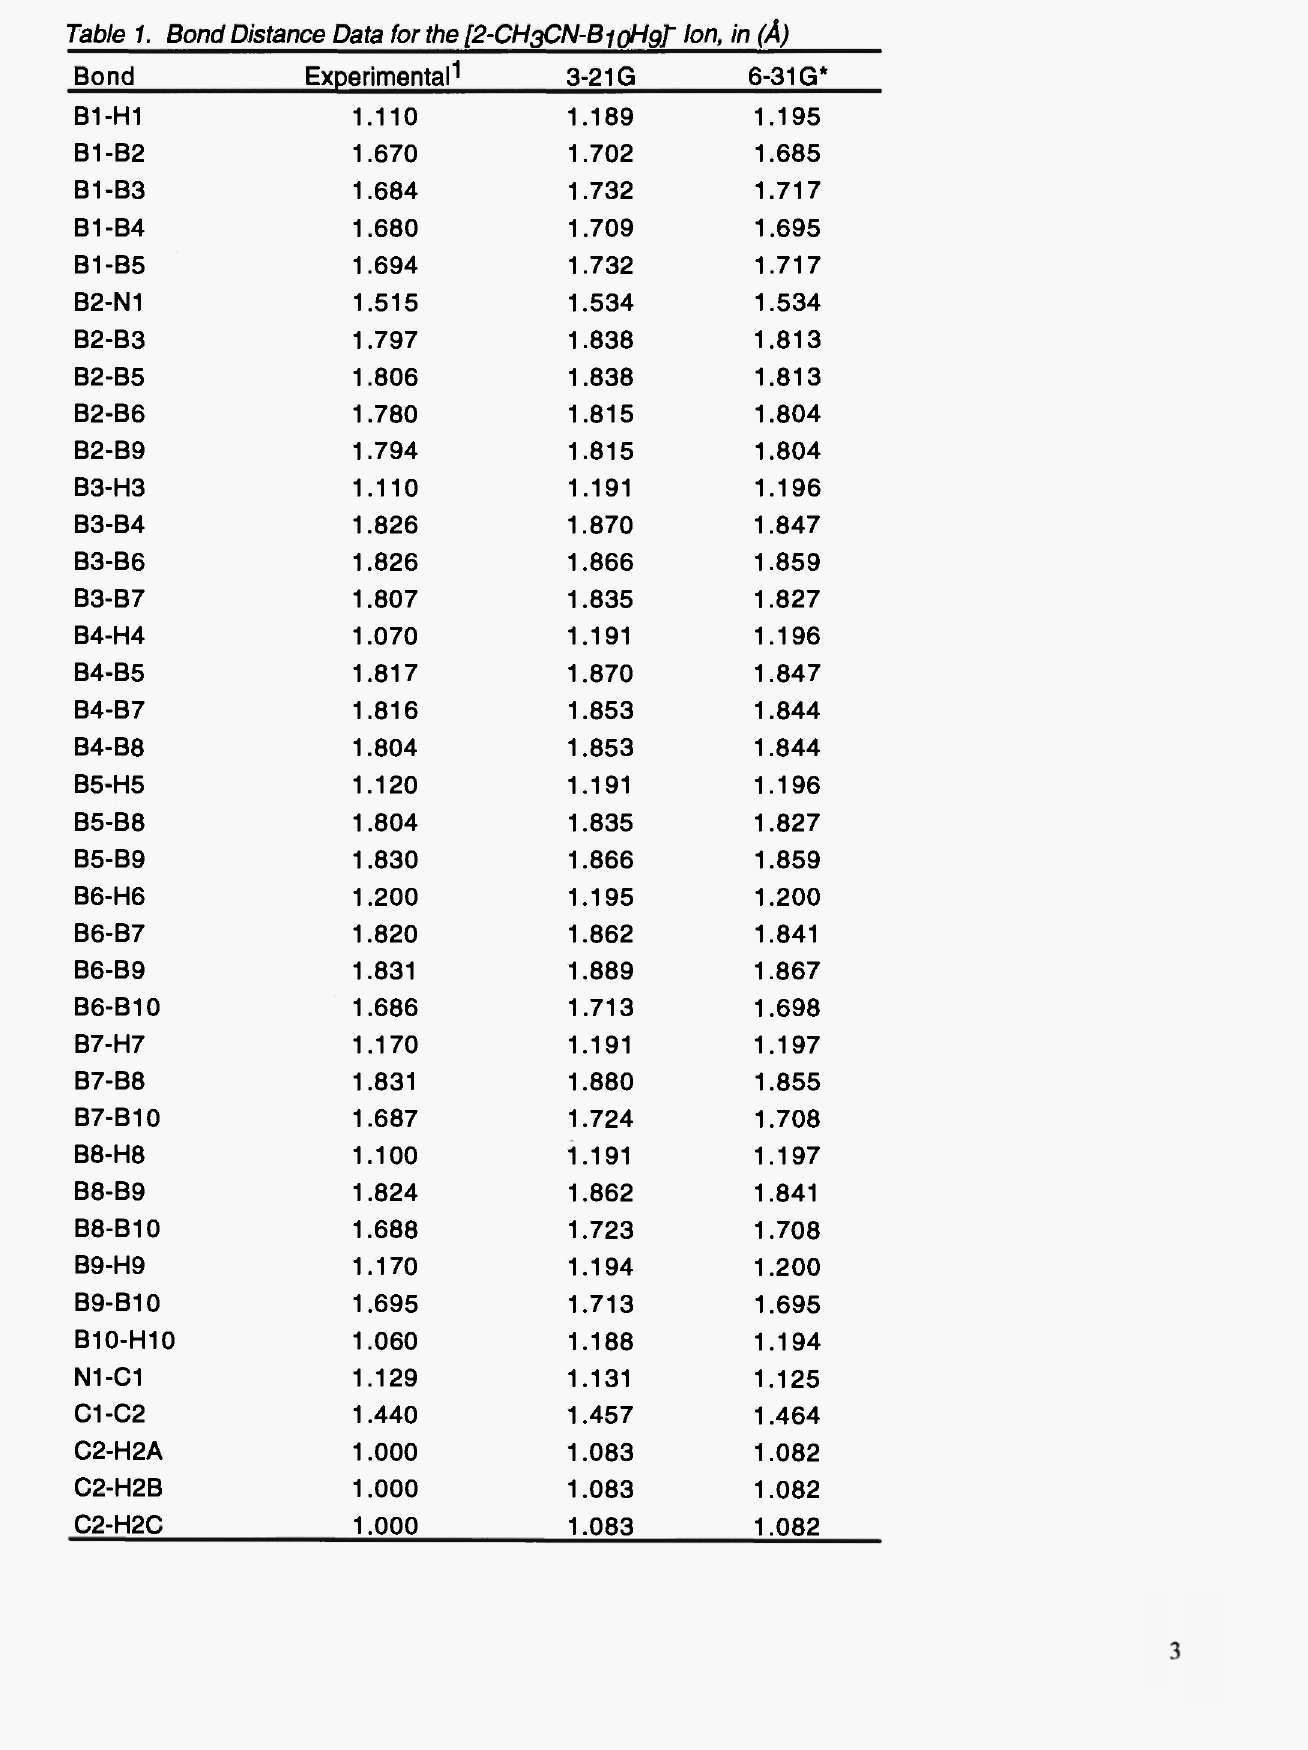
Table 1. Bond Distance Data for the [2-CH3CN-BioHg]- Ion, in (A)